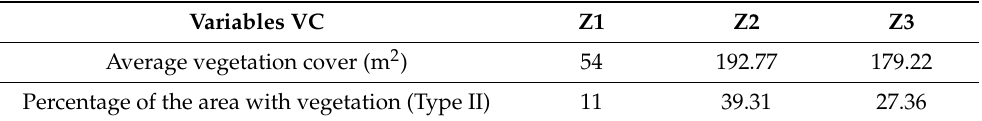
Table 3. Results obtained for the vegetation cover (VC) variables, and for each studied area (Z1, Z2, and Z3). Variables VC Z1 Z2 Z3 Average vegetation cover (m 2 ) 54 192.77 179.22 Percentage of the area with vegetation (Type II) 11 39.31